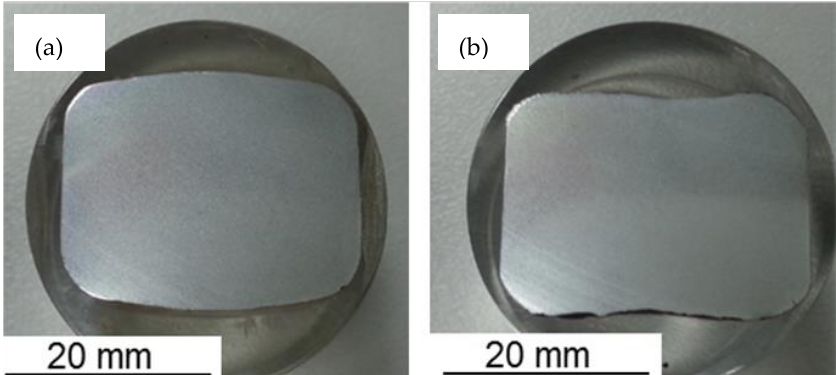
Figure 4. Images of real strips as obtained after rolling through stand 14. ( a ) Strip deformed by grooved rolls, ( b ) strip deformed by grooveless rolls.